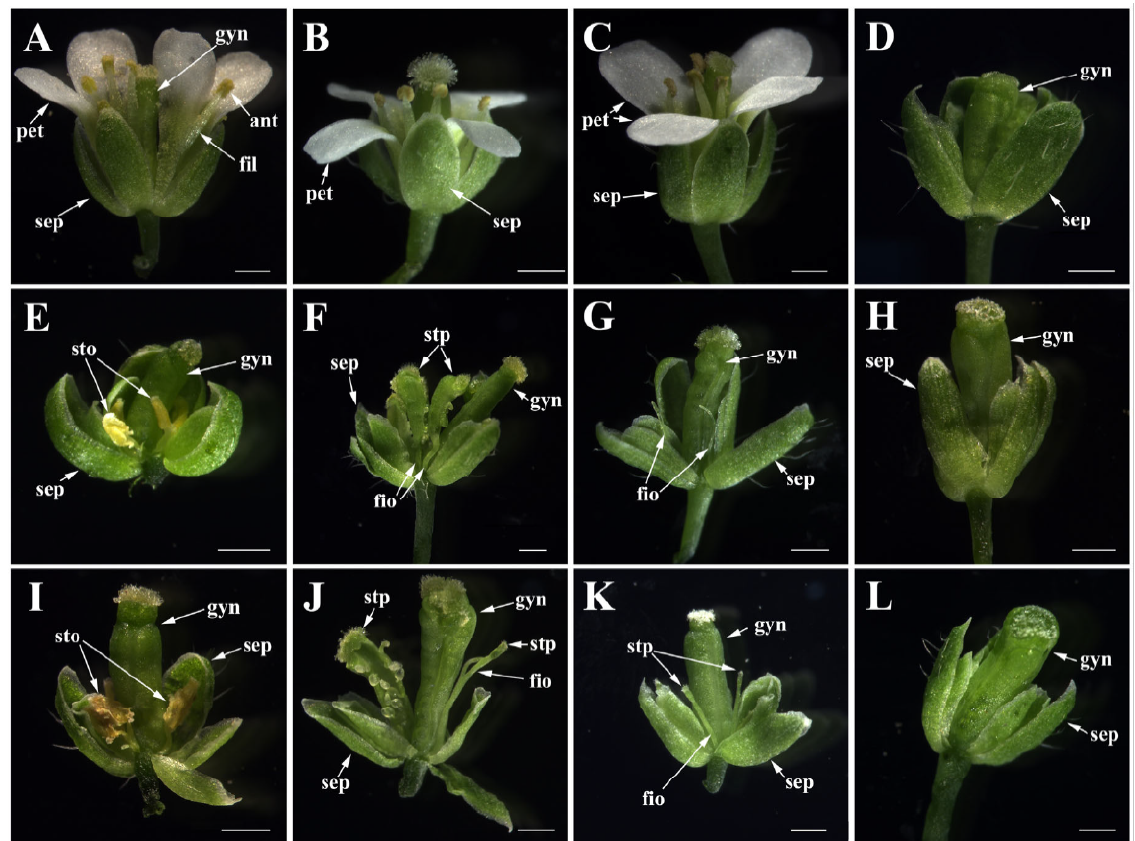
Figure 8. Flower phenotypes comparison of the wild-type, Arabidopsis ap3-3 mutant, 35S::FaesAP3_2 transgenic Arabidopsis ap3-3 mutant and 35S::FaesAP3_2a transgenic Arabidopsis ap3-3 mutant. ( A ) Wild-type Arabidopsis flower with normal flowers (sepal in whorl 1, petal in whorl 2, stamen in whorl 3 and fused carpel in whorl 4); ( B ) flower of 35S::FaesAP3_2 transgenic Arabidopsis under wild-type background; ( C ) flower of 35S::FaesAP3_2a transgenic Arabidopsis under wild-type background; ( D ) flower of Arabidopsis ap3-3 mutant with petal converted into sepal and stamen deficiency in whorl 3; ( E ) flower of 35S::FaesAP3_2 transgenic homozygous ap3-3 Arabidopsis with stamen-like organs in whorl 3; ( F ) flower of 35S::FaesAP3_2 transgenic homozygous ap3-3 Arabidopsis with filament attached with a carpelloid anther in whorl 3; ( G ) flower of 35S::FaesAP3_2 t ransgenic homozygous ap3-3 Arabidopsis with 1~2 filament-like organs in the stamen whorl; ( H ) flower of 35S::FaesAP3_2a transgenic homozygous ap3-3 Arabidopsis without phenotype complementation; ( I ) flower of 35S::FaesAP3_2a transgenic homozygous ap3-3 Arabidopsis with stamen-like organs in whorl 3; ( J ) flower of 35S::FaesAP3_2a transgenic homozygous ap3-3 Arabidopsis with filament attached with stigmatic papillae or carpelloid anther in whorl 3; ( K ) flower of 35S::FaesAP3_2a transgenic homozygous ap3-3 Arabidopsis only with filament-like organs or filament attached with stigmatic papillae in whorl 3; ( L ) flower of 35S::FaesAP3_2a transgenic homozygous ap3-3 Arabidopsis without phenotype complementation. Sepal (sep), petal (pet), anther (ant), filament (fil), filament-like organ (fio), stamen-like organ (sto), gynoecia (gyn), stigmatic papillae (stp); scale bars: 500 µ